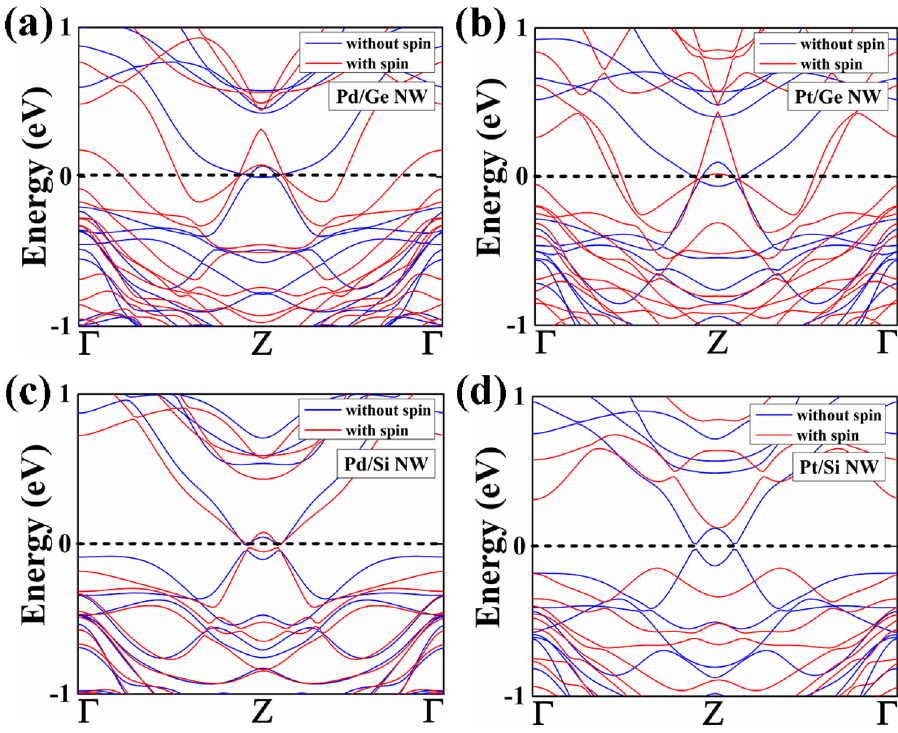
Figure 2. The electronic band structure without spin–orbit interaction and within spin–orbit interaction of ( a ) Pd/Ge, ( b ) Pt/Ge, ( c ) Pd/Si and ( d ) Pt/Si NWs having diameter of 1.4 ~ 1.5 nm (1R) is shown. The Fermi level is set at 0